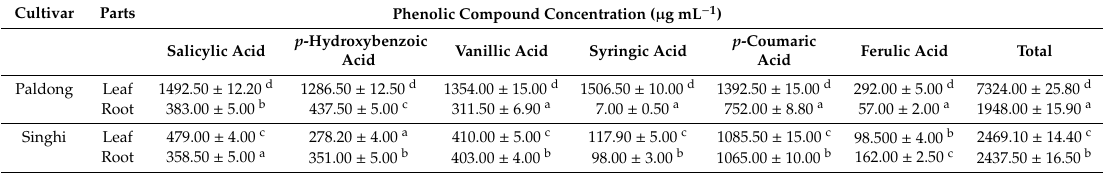
Table 3. Identification of phenolic compounds from the di ff erent tissues and cultivars of S. cereale .